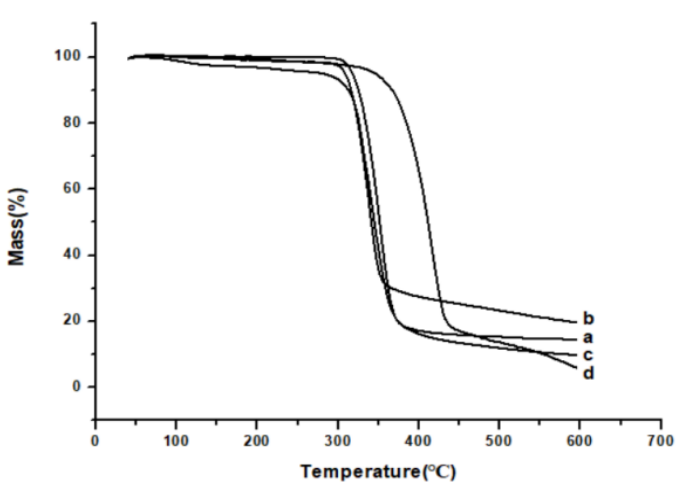
Figure 8. TG results of samples. (a) Raw API, (b) API nanoparticles, (c) API and HP- β -CD mixture, and (d) HP- β -CD.